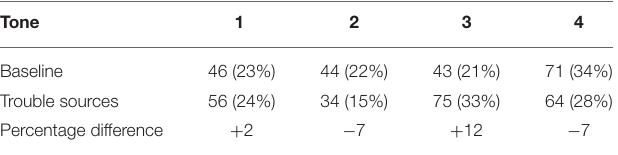
TABLE 4 | Counts (and percentages) of different tonemes in Mandarin in general (baseline from Wan and Jaeger, 1998), and in conversational turns that lead to open repair (from Dingemanse et al., 2015).